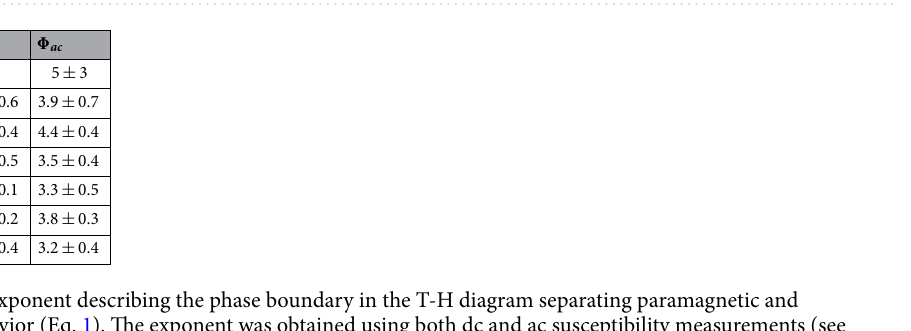
0.5 member of the solid solution with dc fields ranging from 100 to Figure 4. (a) FC-ZFC curves for the x = 500 Oe. Arrows indicate the peak in the ZFC curve. Curves have been shifted along the y-axis for comparison, (b) T p as a function of applied field H for three of the solution members. Lines indicate fits to Eq. (1).